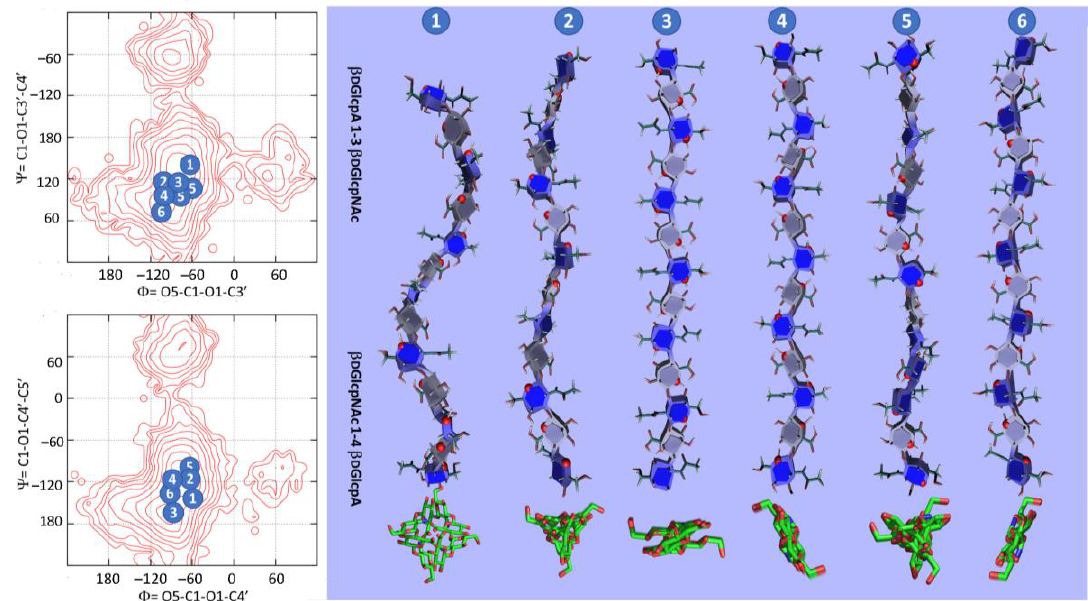
Figure 8. Stable regular helical conformation of single-stranded hyaluronic acid projected parallel and orthogonal to their axes (drawn with SweetUnityMol [82]). The Φ and Ψ conformations are shown on the corresponding potential energy surfaces.